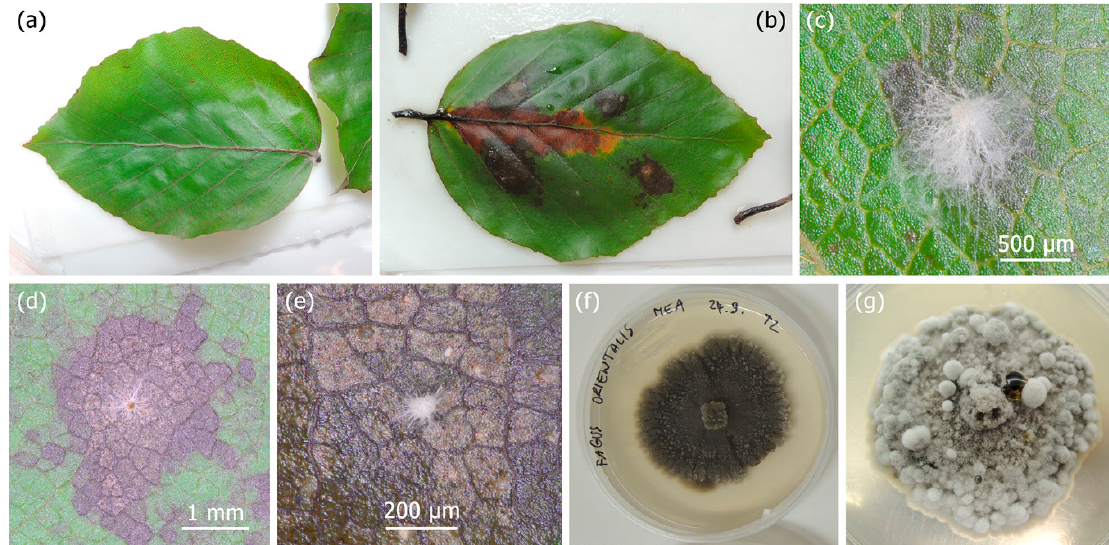
Figure 4. Pathogenicity test on Fagus orientalis : ( a ) Control on the 21st day; ( b ) necrotic leaf spots on the 21st day; ( c ) a lesion developed under a propagule on the 2nd day; ( d ) lesion under a propagule on the 11th day; ( e ) newly formed mycopappus-like propagule on a necrotic spot on the 14th day; ( f , g ) re-isolation from newly formed mycopappus-like propagule on MEA and PDA, respectively.